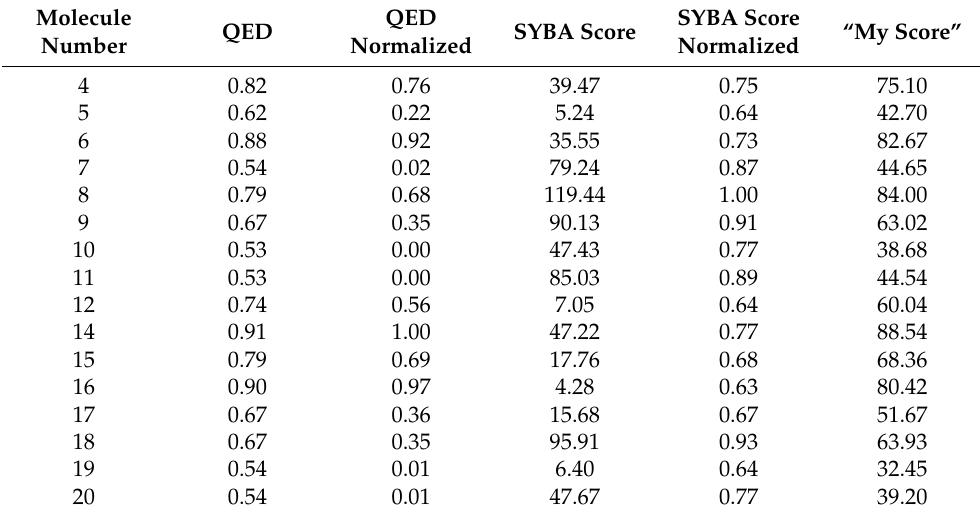
Table 2. “My score”, QED normalized, and SYBA scores normalized, see SM Equation (S3) for selected structures with SM File S29; all structures meet the QED threshold and Lipinski’s rule of 5. They are used to determine the normalized QED and SYBA scores and “My score” (see SM File S41). SYBA Score QED Molecule “My SYBA Score QED Normalized Normalized Number